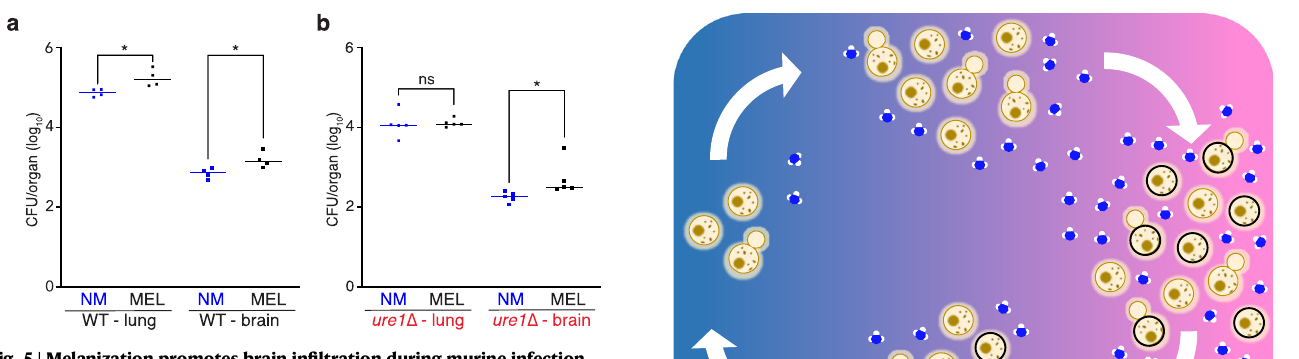
Fig. 5 | Melanization promotes brain in fi ltration during murine infection. Quanti fi ed fungal burden in the lungs and brains of mice 24h after intravenous infection with 2×10 5 macrophages carrying NM or MEL WT (( a ) n =4, * p =0.0167 and0.0300forlungandbrain,respectively;unpaired,two-sided parametric t -test) or ure1 Δ (( b ) n =5, NS not signi fi cant, * p =0.0414 for brain; unpaired, two-sided parametric t -test). Source data are provided as a Source Data fi